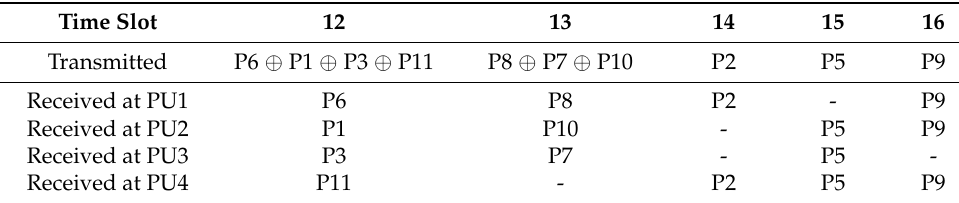
Table 2. Lost packets retransmissions using NC −